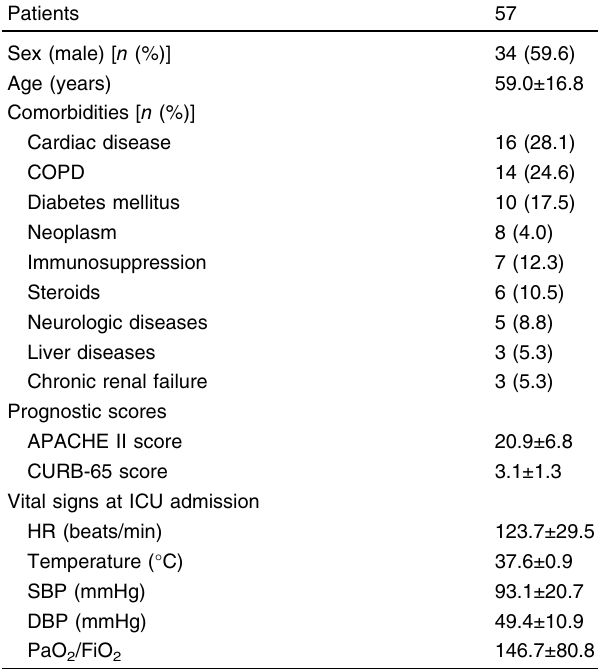
Table 1 Patient characteristics and underlying conditions Patients